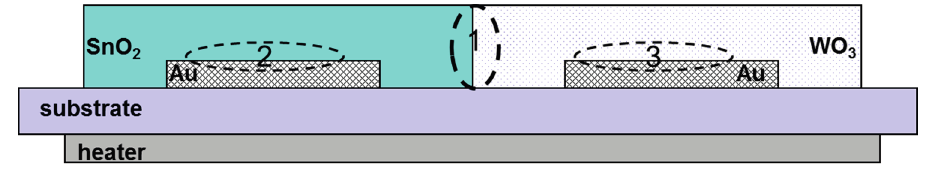
Figure 12. Schematic diagram of the cross-section of the sensor with a